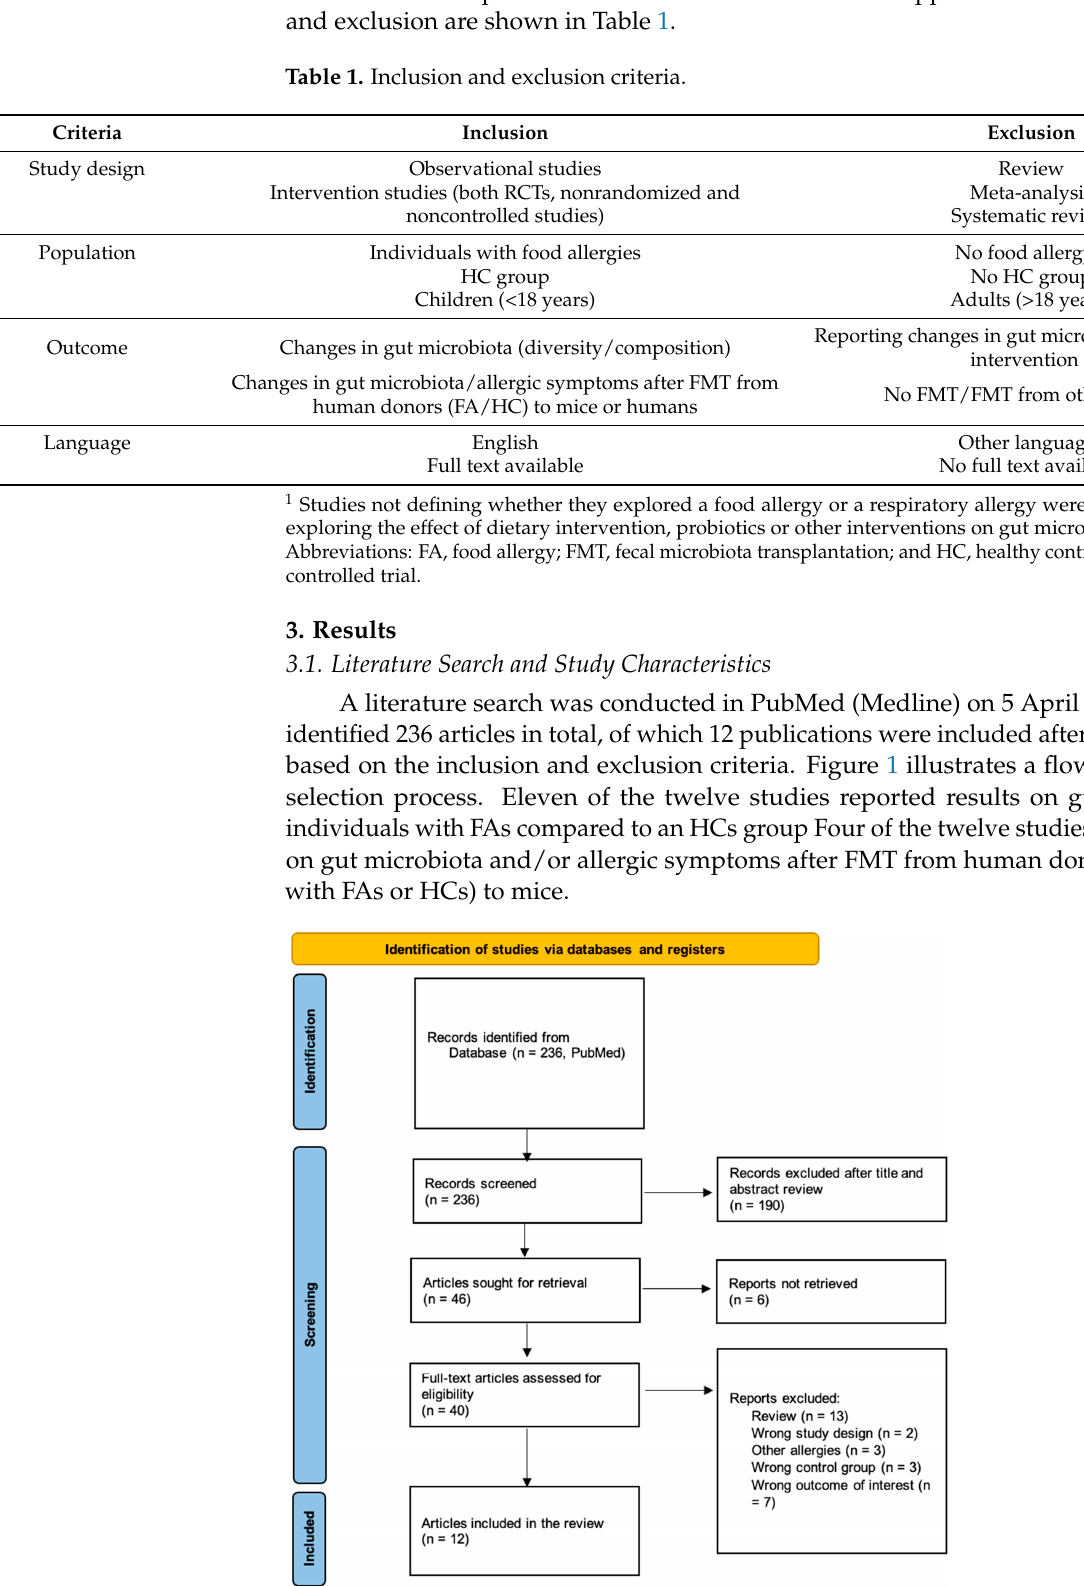
Figure 1. PRISMA (Preferred Reporting Items for Systematic Reviews and Meta-Analyses) flow di- agram [18] depicting the literature search in PubMed (Medline) and the screening process for this systematic